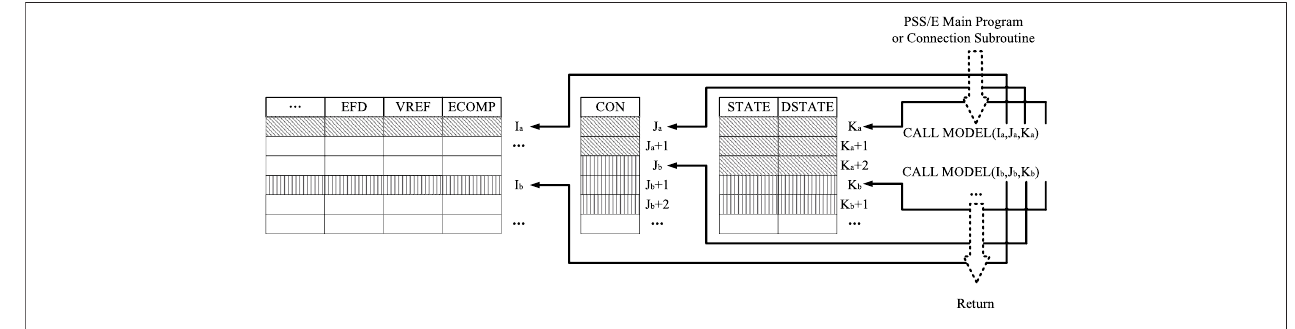
FIGURE 2 | Mechanisms for storage space allocation of internal arrays in PSS/E. The fl ow of dynamic simulation for UDM